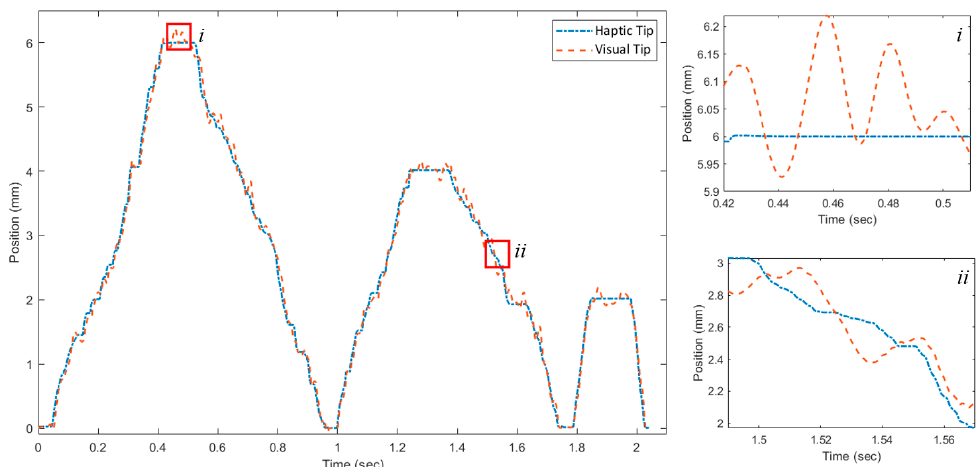
Figure 13. Contact point deflection versus time plots of the haptic-tip and the visual tip. i and ii are zoomed-in regions.